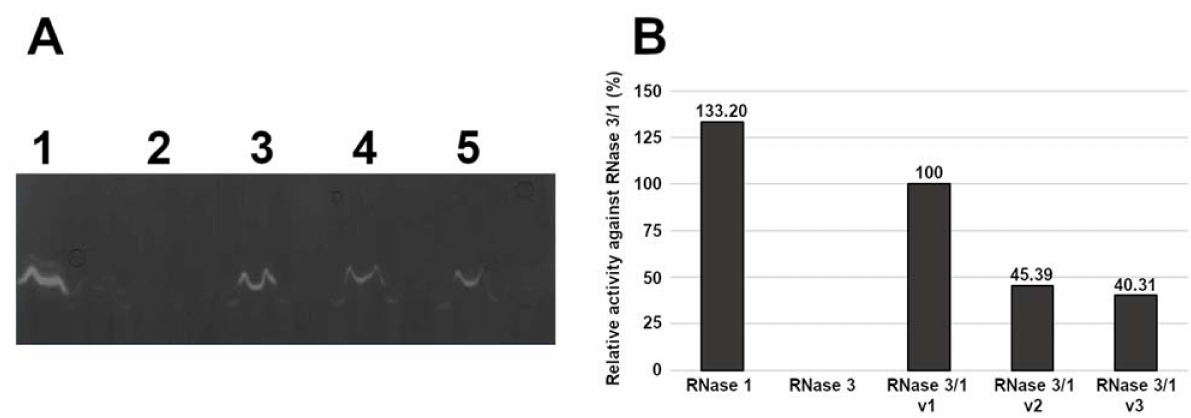
Figure 3. ( A ) Activity staining gel showing the degradation of poly(U) with 15 ng of each protein. RNase 1 (lane 1), RNase 3 (lane 2), RNase 3/1-v1 (lane 3), RNase 3/1-v2 (lane 4) and RNase 3/1-v3 (lane 5). ( B ) Densitometric analysis of the bands of the activity staining gel. Activity is represented as relative activity compared to RNase 3/1-v1. Quantification was conducted from a scan image using Quantity One software (Bio-Rad ® ,Hercules, CA, USA). Table 1. Comparison of the relative catalytic activity against dinucleotides. Values of relative activity are calculated from the average of three replicates, considering RNase 3/1-v1 as 100% of activity. Relative Catalytic Activity against Dinucleotides RNase 1 RNase 3 RNase 3/1-v1 RNase 3/1-v2 RNase 3/1-v3 CpA 641 22 100 37 35 UpA 940 1 100 73 130 UpG 124 N.D. 100 23